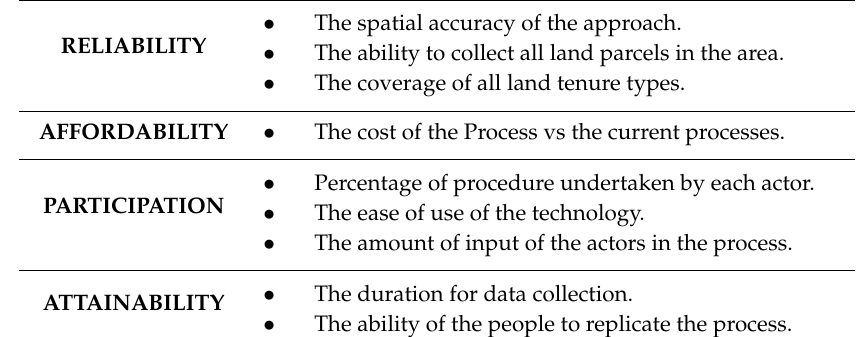
Table 1. Summary of Assessment Elements and